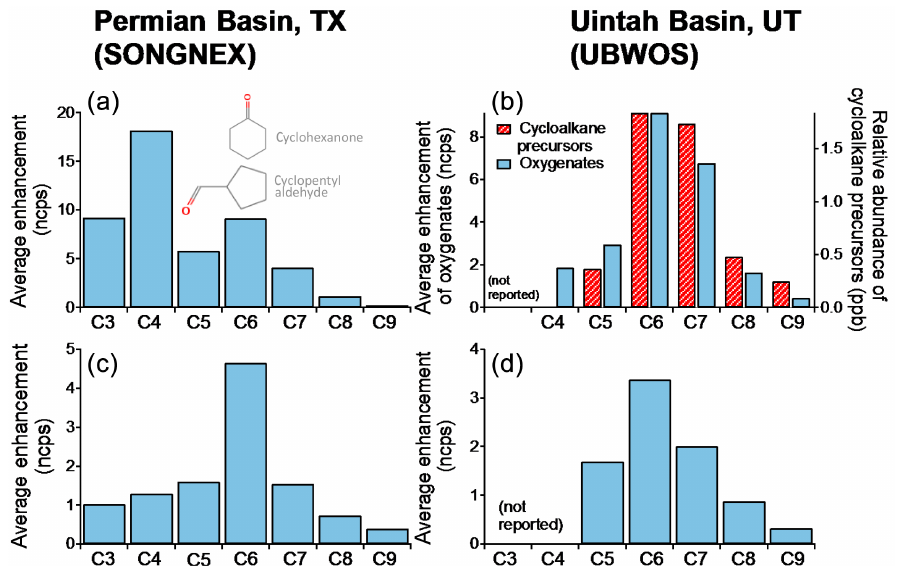
Figure 11. Ion masses related to cycloalkane oxidation products. The x axis is the number of carbons in the molecule. (a) C x H 2 x − 2 O oxygenates measured in the Permian Basin during SONGNEX. (b) Cycloalkane precursors (measured by GC) and C x H 2 x − 2 O oxygenates measured in the Uintah Basin during UBWOS. Panels (a) and (b) show the same ion masses. (c) Possible dehydration masses (C x H 2 x − 4 O) of the oxygenates shown in (a) , measured in the Permian Basin. (d) Possible dehydration masses of the oxygenates shown in (b) , measured in the Uintah